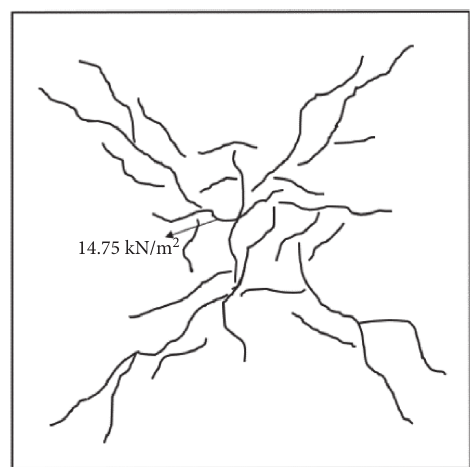
Figure 4: Fracture distribution of wall